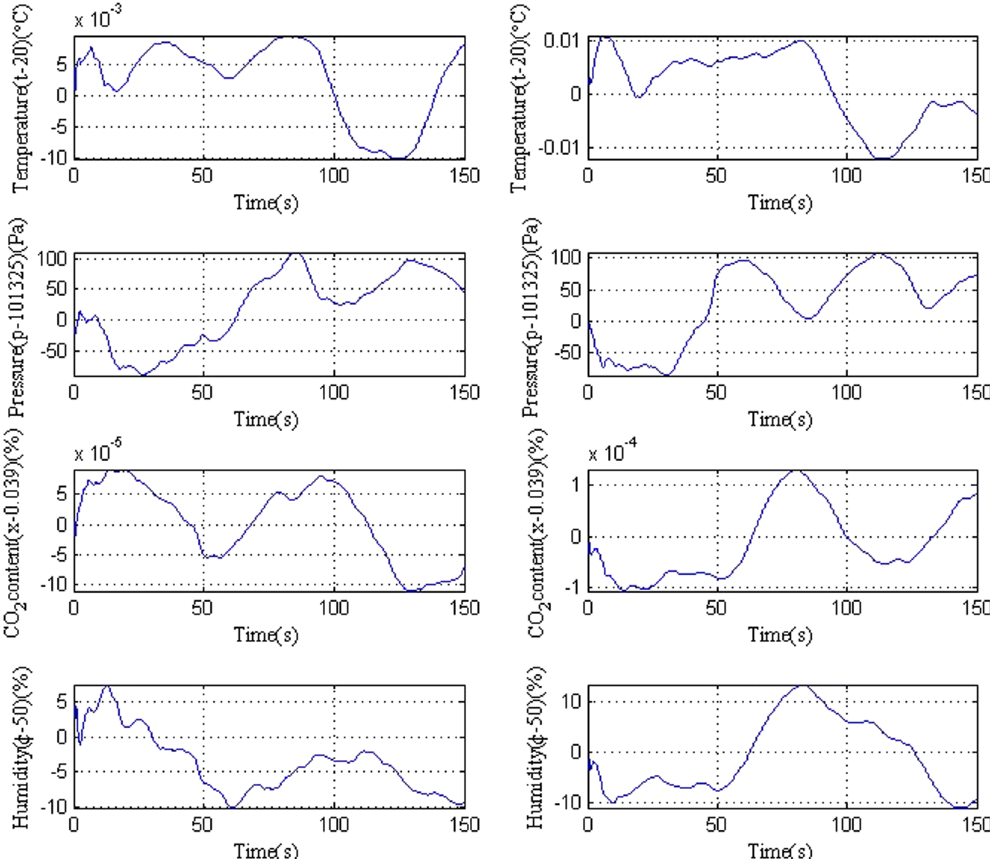
Figure 2. The change in the characteristics of the air: ( a ) the change in the measurement using the left optical path before the stage mirror; ( b ) the change in the measurement using the right optical path after the stage mirror.